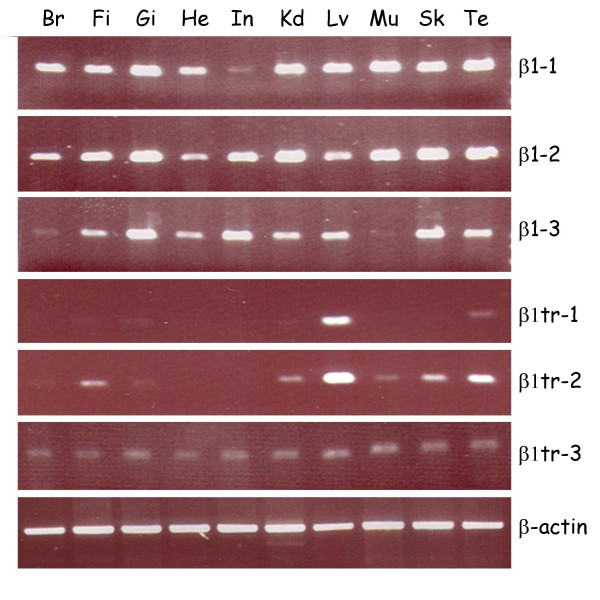
Expression profiling of zebrafish β1 paralogs in adult tissues. Expression of the different paralogs was analyzed by semiquantitative RT-PCR using primers designed against a portion of extracellular domains of the different paralogs. The amplification of zebrafish β-actin was monitored as a positive control. Br, brain; Fi, fin; Gi, gill; He, heart; In, intestine; Kd, kidney; Lv, liver; Mu, muscle; Sk, skin; Te, testis.